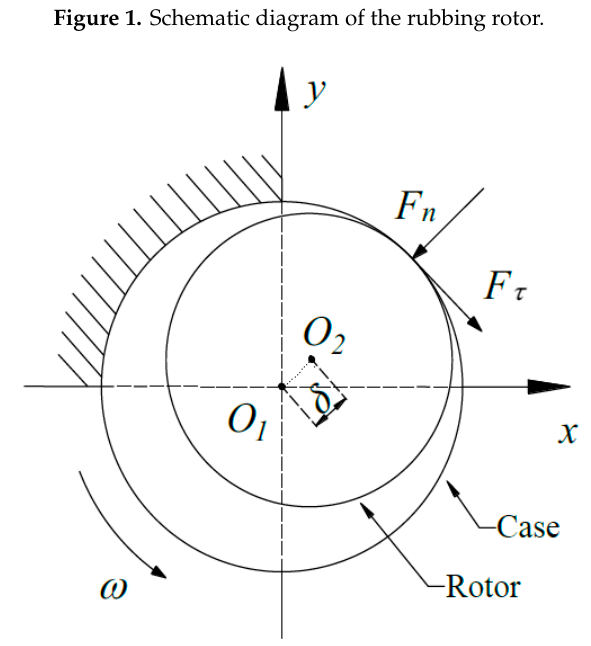
Figure 2. Rotor / case contacting